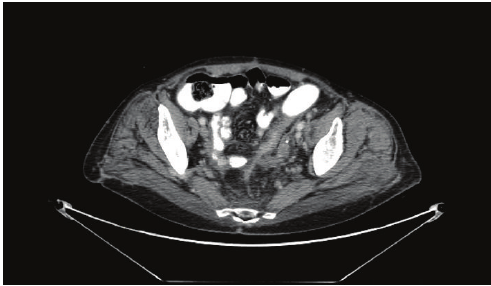
Figure 1: CT scan showing free air in the abdomen.